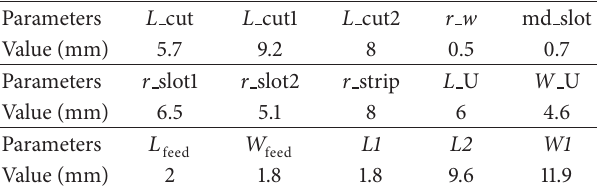
Table 1: Optimized parameters of the quad band-notched